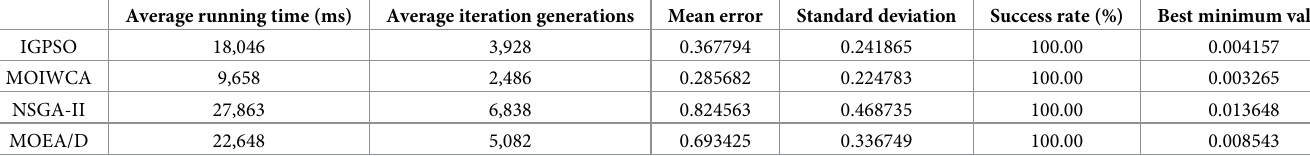
Table 2. Comparison of test results of Rastrigin function using MOIWCA, IGPSO, NSGA-II and MOEA/D. Average running time (ms)